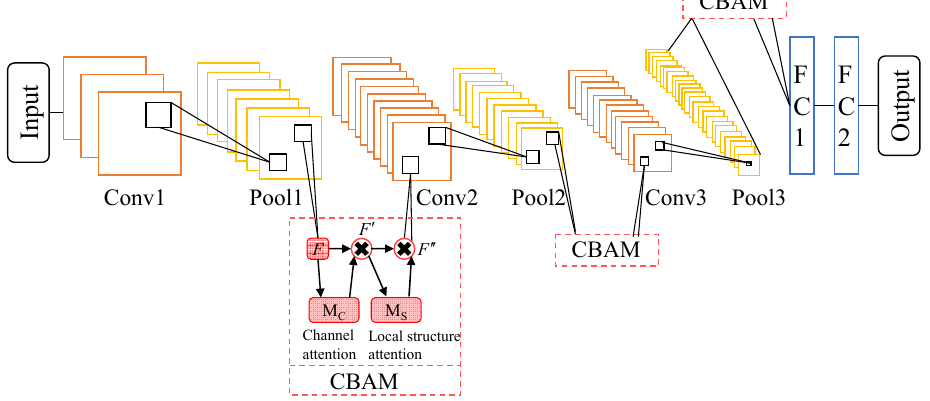
Figure 7. The compared 2-D CNN+CBAM configuration. Table 3. Structural parameters of the ResNet+CBAM network.